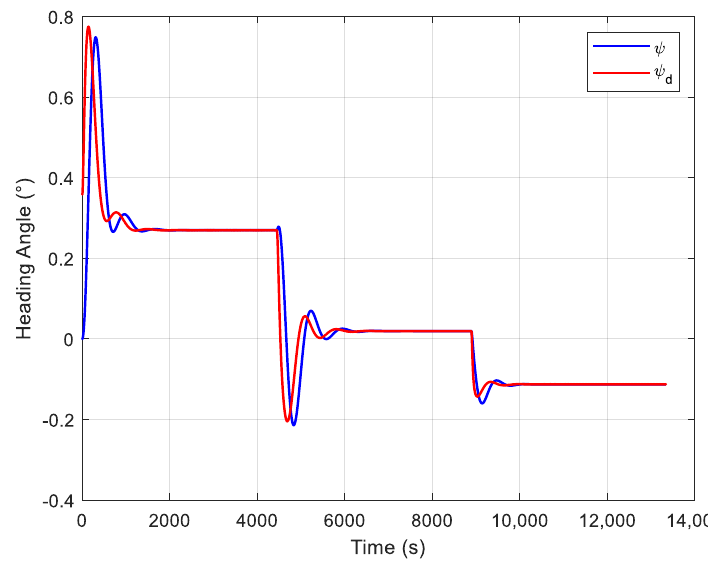
Figure 9. The desired heading angle vs. the true heading angle in the proposed guidance law at y d = 0.05 L